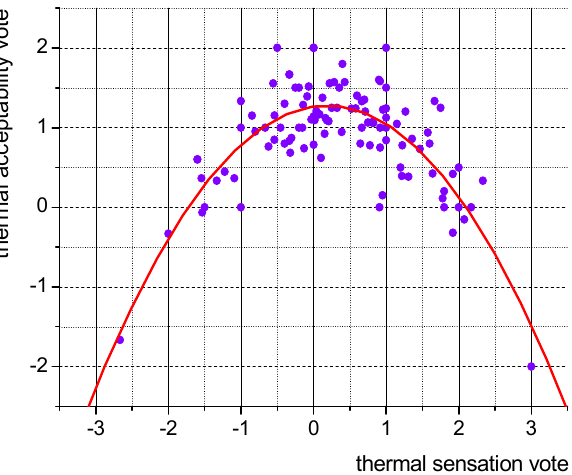
Figure 14. Thermal acceptability vote vs. thermal sensation vote—data for all the buildings, the red line represents the approximation curve, while the purple dots the average values of TAV.